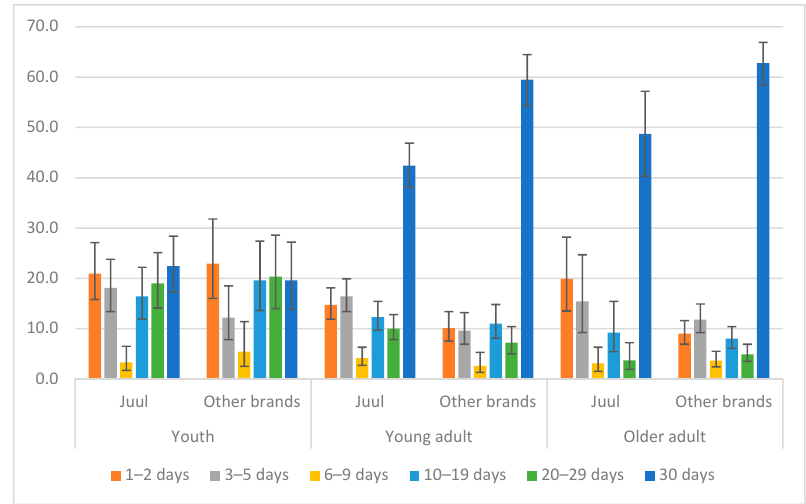
Figure 2. Percentages of JUUL users vs. users of other e-cigarette brands by use frequency and age group.